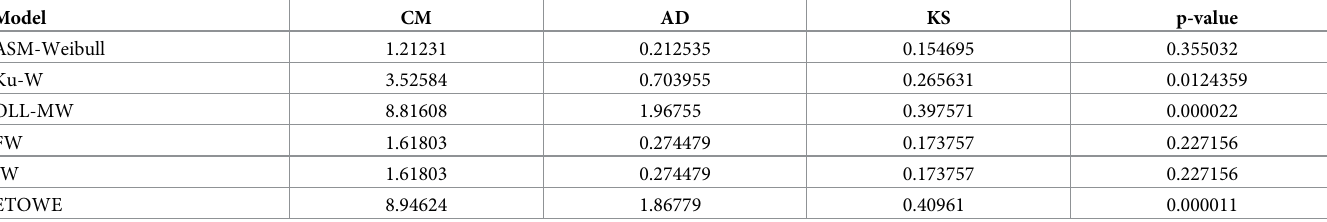
Table 11. Corresponding to the second COVID-19 data, the goodness of fit measures of the fitted models.